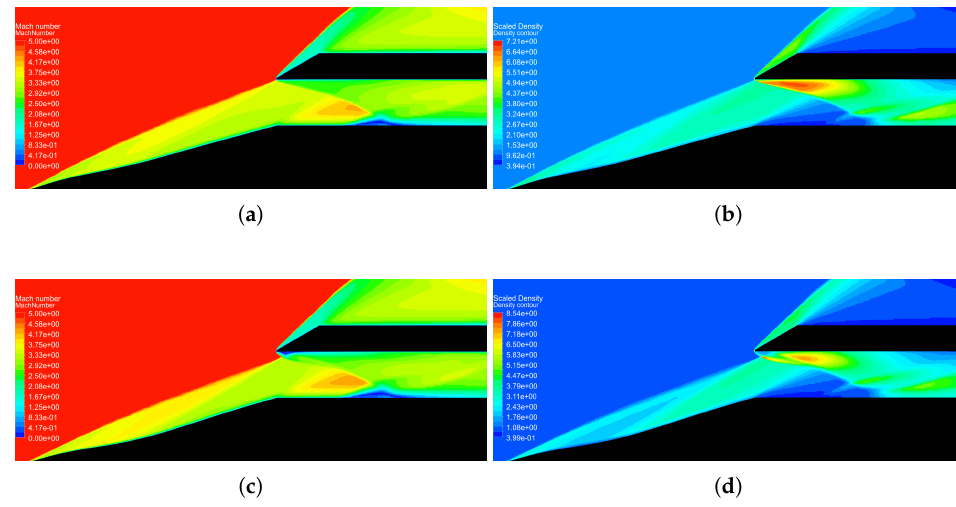
Figure 15. Mach number and scaled density contours for tri-objective optimized solutions. ( a ) Mach number contour C d —optimum; ( b ) Density contour C d —optimum; ( c ) Mach number contour SPR — optimum; ( d ) Density contour SPR